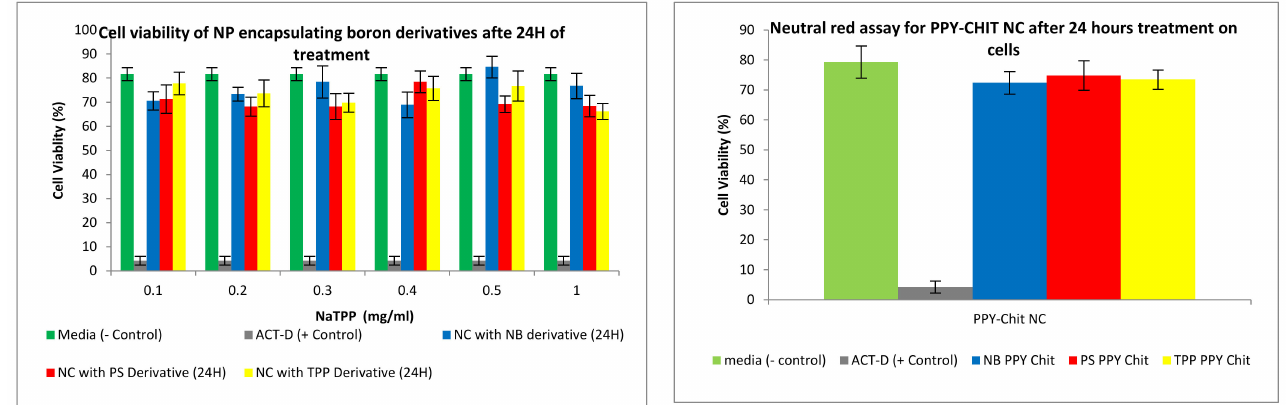
Figure 14. Neutral red assay for nanocomposites formulated via ionotropic gelation treated on CaCo2 cell lines. Cell lines were tested on compound 2 (TPP), compound 4 (NB) and compound 6 (PS).